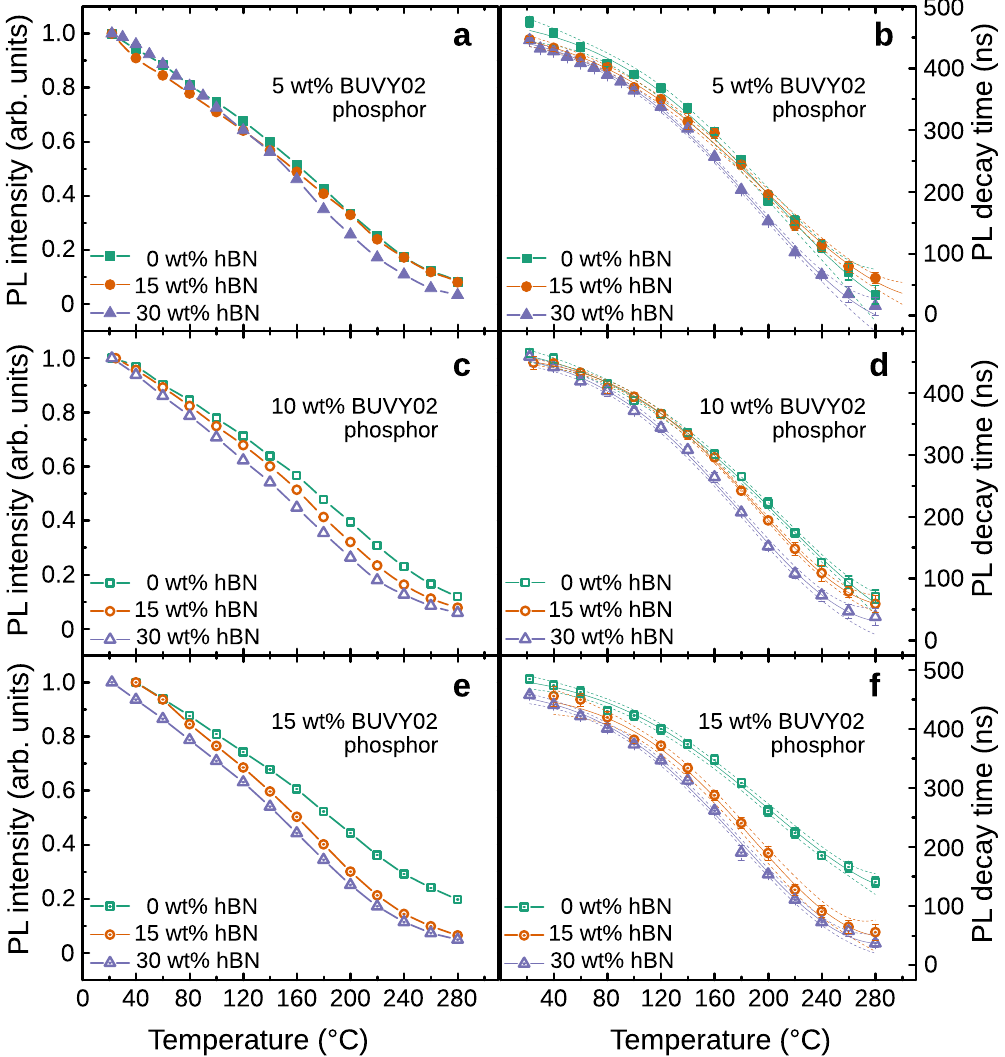
Figure 4. Calibration curves used for the phosphor thermometry. ( a ), ( c ), and ( e ) present the dependence of the PL intensity of the converters for different hBN concentrations containing 5, 10 and 15 wt% of BUVY02 phosphor, respectively. ( b ), ( d ), and ( f ) present the PL decay time values of the converters for different hBN concentrations containing 5, 10 and 15 wt% of BUVY02 phosphor, respectively. Solid lines represent the least square fits to the experimental data and the dashed lines show the 95% confidence